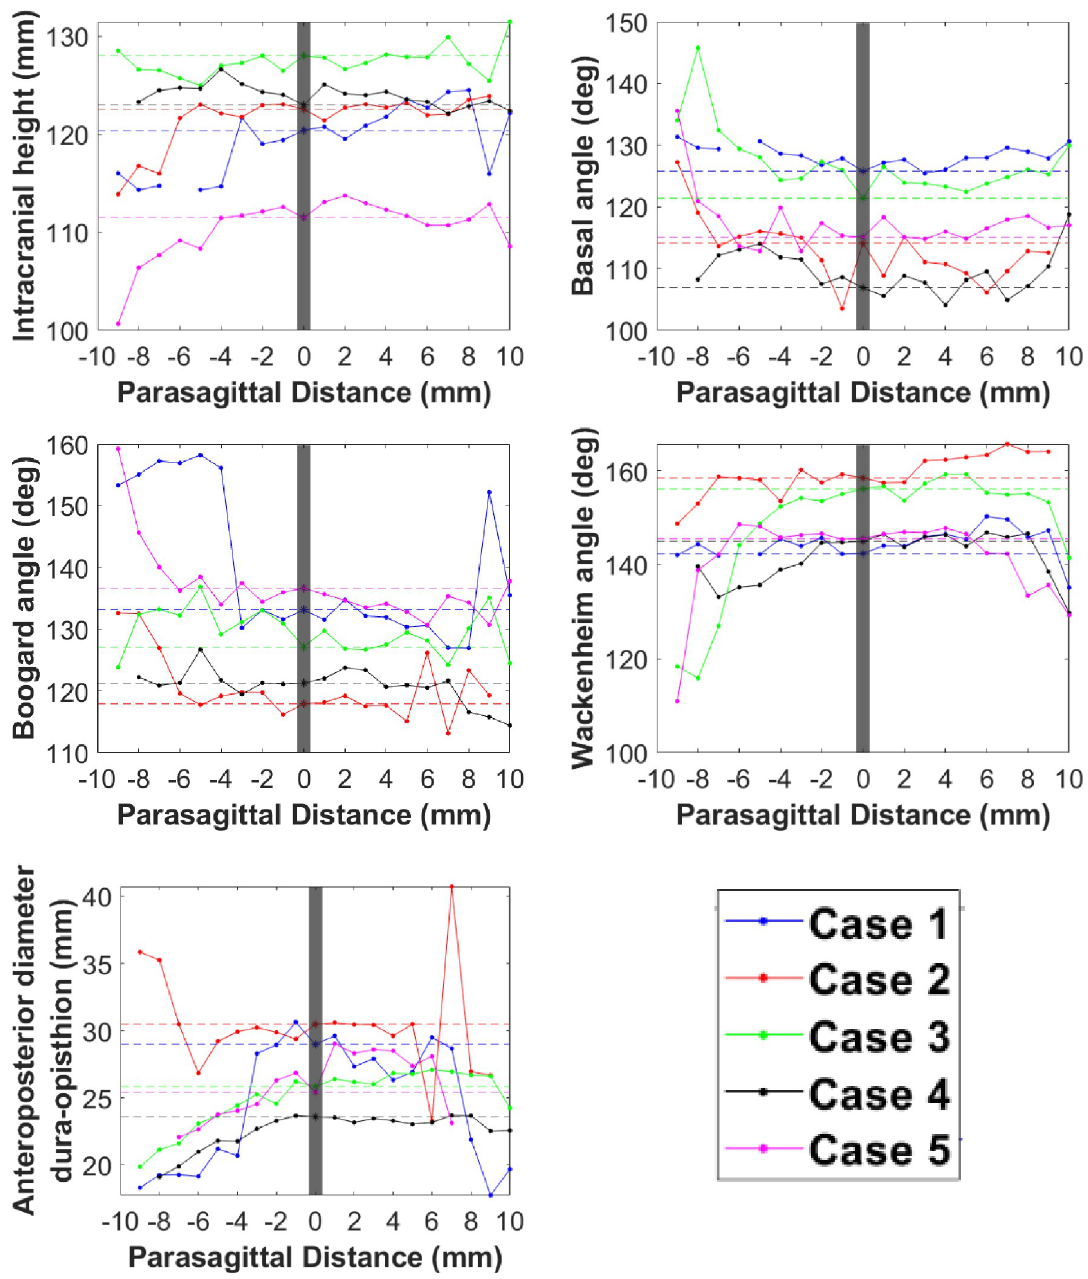
Fig 6. Symmetry plots showing parameters that maintain lateral symmetry up to 3 mm from the midsagittal plane. and four parasagittal planes located 1 and 2 mm lateral (left and right) to the midsagittal plane. The mean individual absolute parasagittal error (MIAPE) is calculated as the mean value of the absolute parasagittal error (unsigned difference between midsagittal and parasagittal morpho- metric measurement) for a given parameter. The mean group parasagittal error (MGPE) is cal- culated as the mean value of a morphometric parameter at a particular lateral distance minus the mean value of the morphometric parameter at the midsagittal plane.